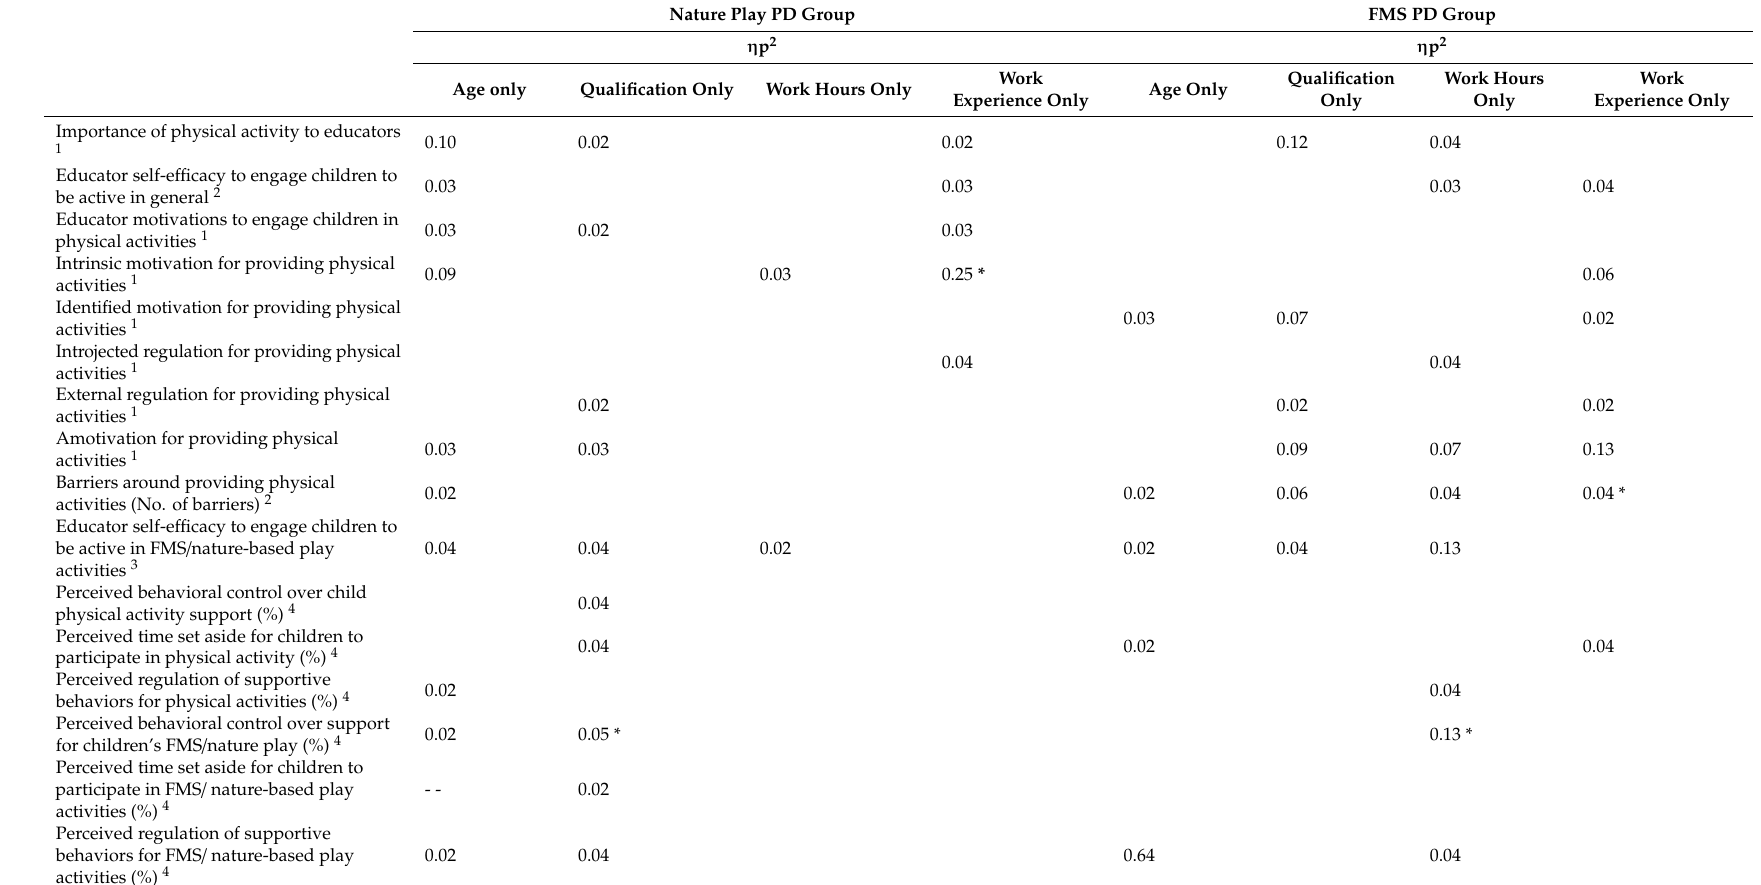
Table 3. E ff ect size of educator socio-demographic